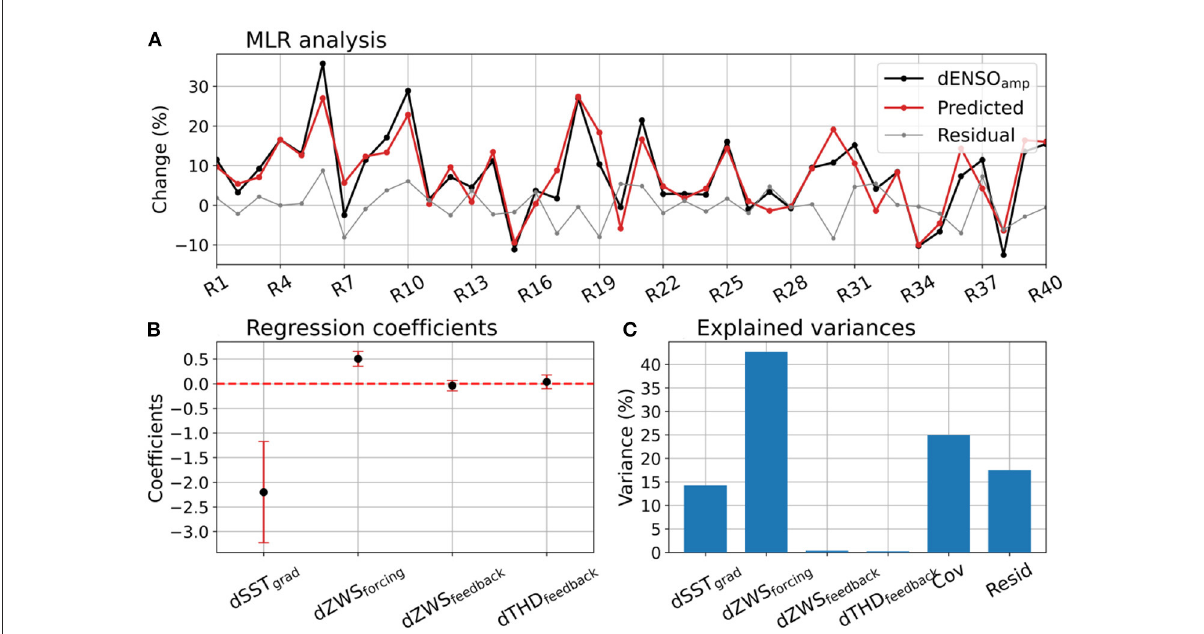
FIGURE5 Contributions of different ENSO processes to the ensemble variation of ENSO amplitude changes under global warming, as assessed by a multiple linear regression (MLR) model. (A) ENSO amplitude changes in different ensemble members (black curve), ENSO amplitude changes predicted by the MLR (red curve), and the residuals (gray curve); (B) the regression coefficients and their 5–95% confidence intervals (estimated by a two-sided t -test); and (C) percentage (ensemble) variances of ENSO amplitude changes explained by different ENSO processes, as well as the covariance and residual contributions. The GW-induced changes (SSP3-7.0 minus historical) for different ensemble members are expressed as percentages of the respective historical experiment